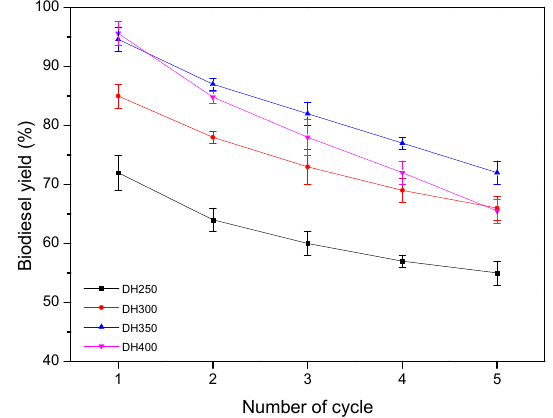
Figure 7. Reusability study of the